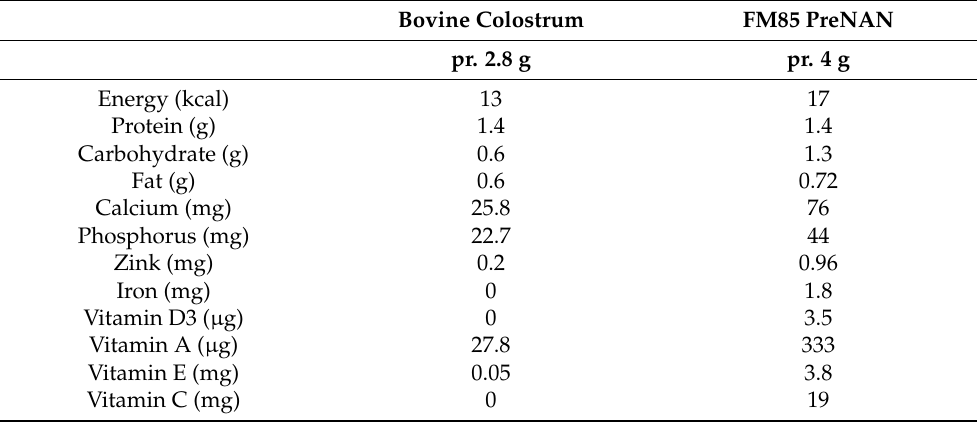
Table 1. Nutrient supply of bovine colostrum and the conventional fortifier (FM85 PreNAN) when the maximum fortification reached pr. 100 mL of human